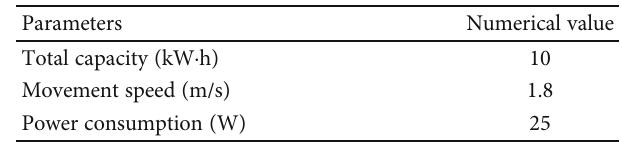
Table 4: Mobile-charging car